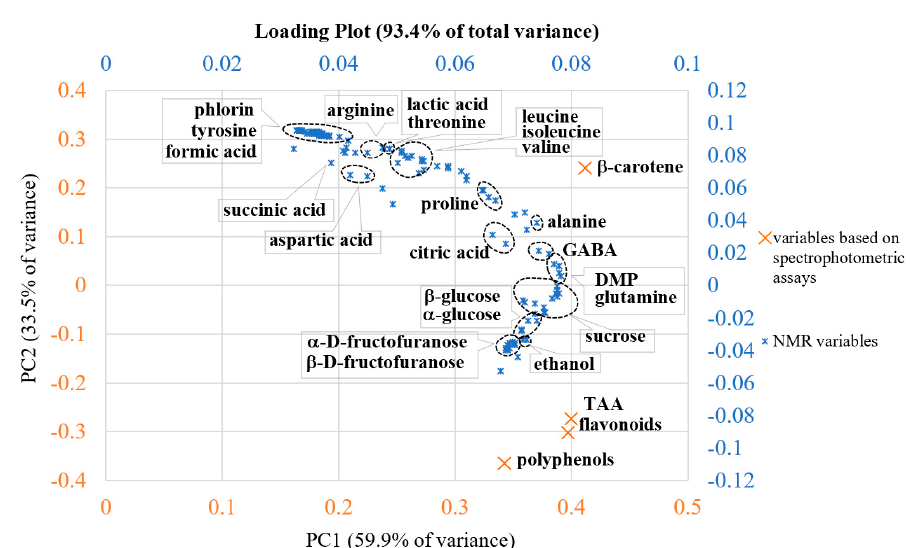
Figure 9. Principal component analysis loadings plot of the studied UF/DF samples using NMR and UV—Vis data.